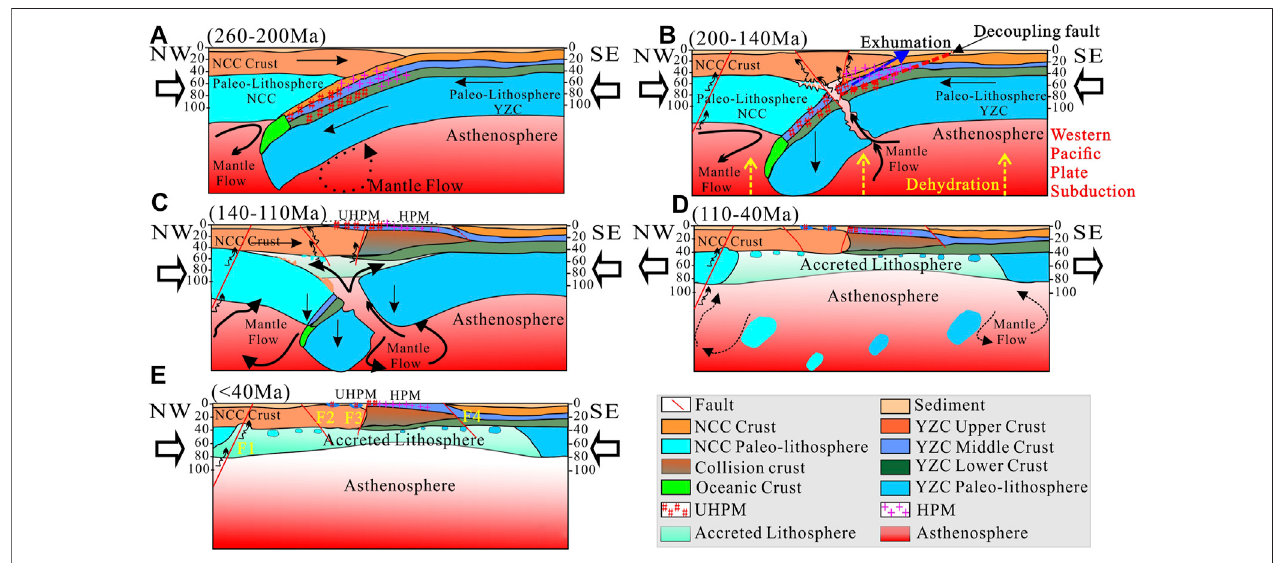
FIGURE10| The sketchmap ofthecollision process between theYZCand the NCC. (A) 260 – 200 Ma, (B) 200 – 140 Ma, (C) 140 – 110 Ma, (D) 110 – 40 Ma, (E) < 40 Ma, respectively. The arrows outside orient the direction of the principal stress fi eld, the arrows inside are directions of mantle fl ow and upwelling of the deep materials, redlinesarethegreatfaultswith namesin yellowtexts, includingF1:Tanlu Fault, F2:Lianyanfault; F3: Muping-Jimofault; andF4, Jiashan-Xiangshuifault. In Figure 10B, theblue arrow indicates theexhumation of deep material, and the yellow dashed arrows indicatethe dehydration ofthe subducted Paci fi c plate.